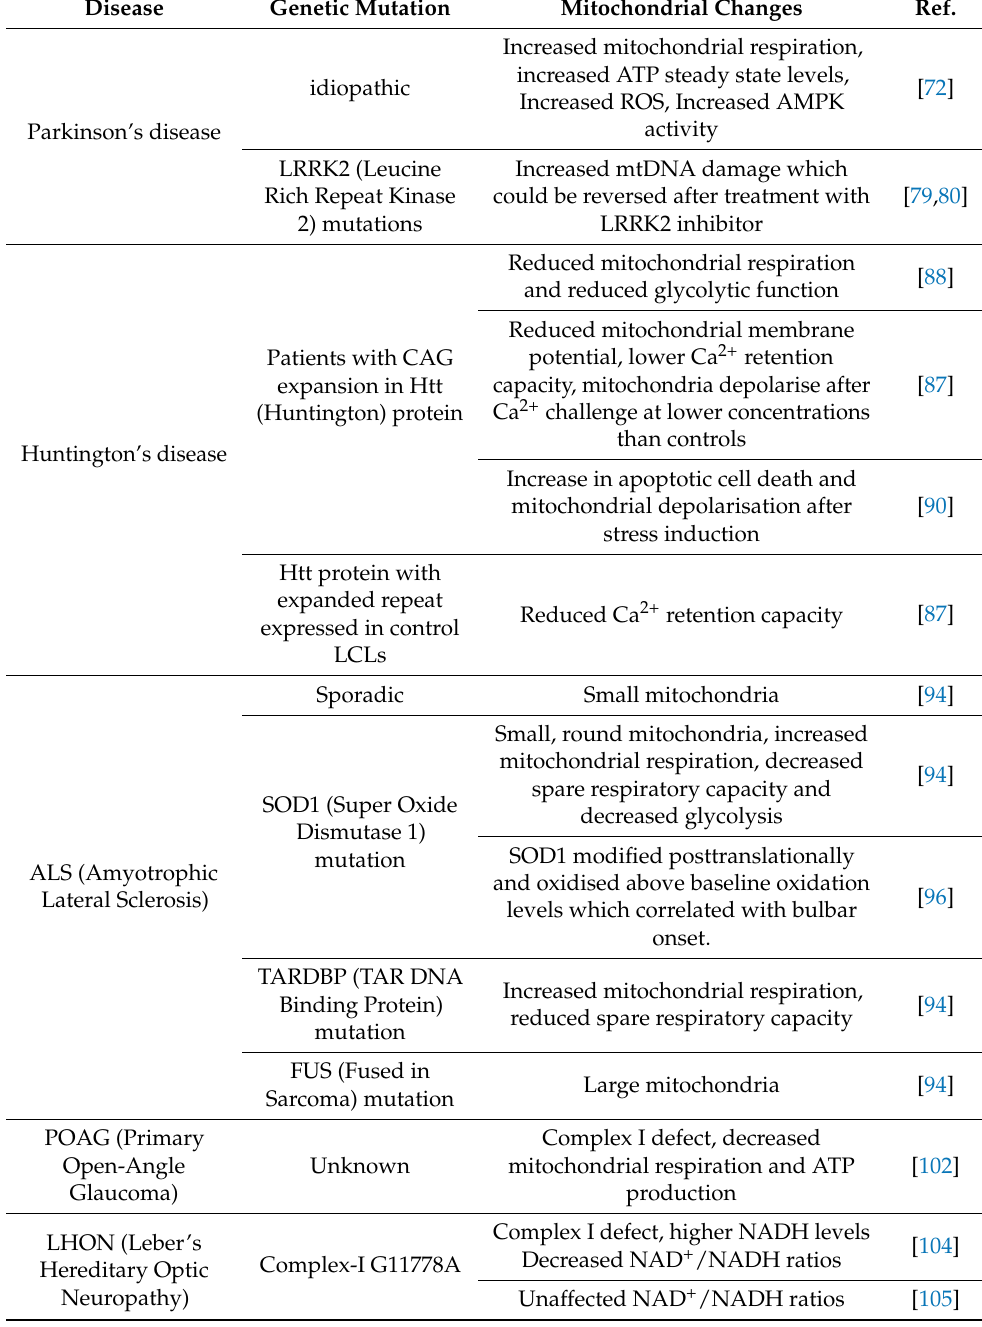
Table 1. Mitochondrial changes in LCL models of neurological